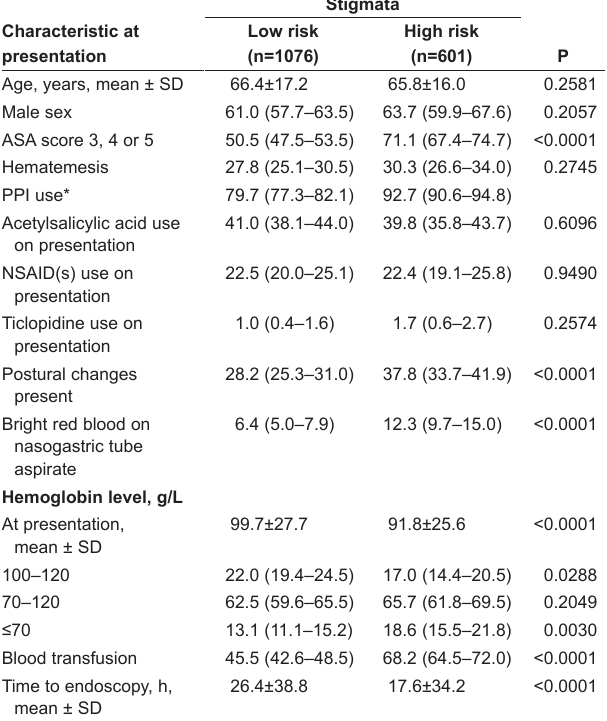
TAble 2 Multivariable analysis of clinical and laboratory predictors